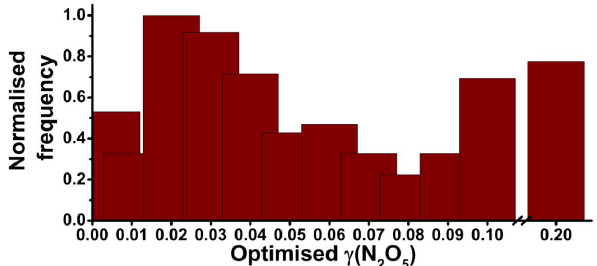
Figure 13: Normalised probability distribution function for optimised values of γ N2O5 . Fig. 13. Normalised probability distribution function for optimised values of γ N 2 O 5